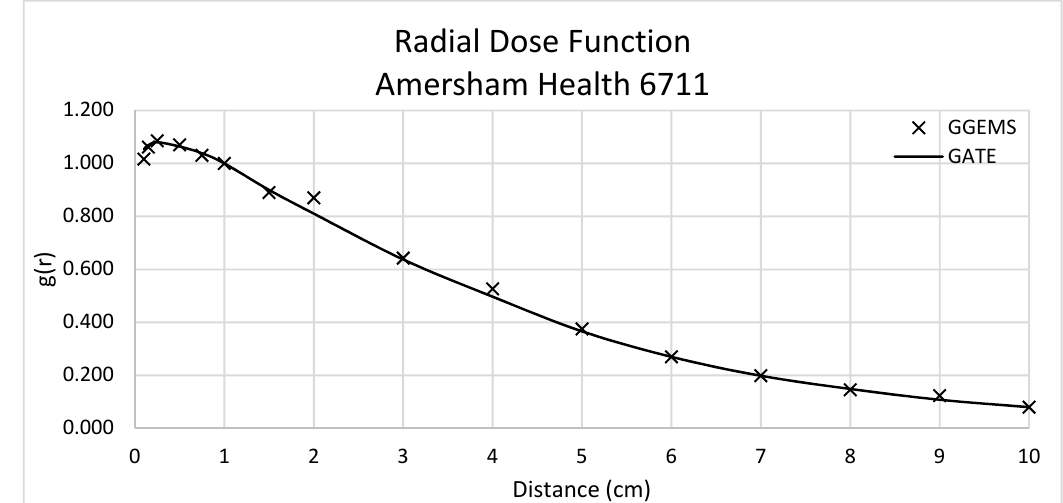
Figure 4. Radial Dose Function for Amersham Health 6711 (LDR). Comparison between GATE and GGEMS simulation results.